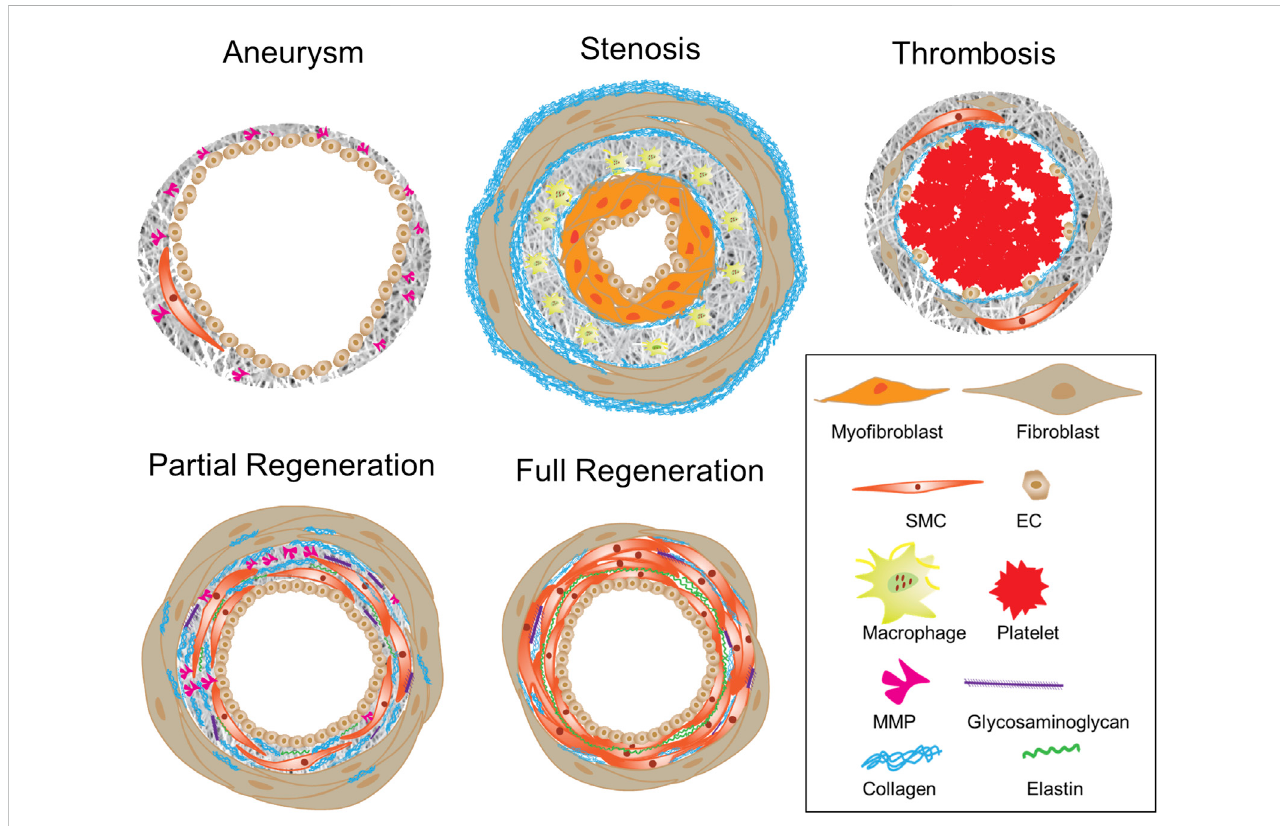
FIGURE 3 Adverse remodeling versus regeneration of a vascular